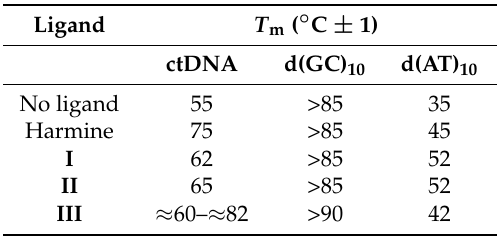
Figure 4. Normalised UV thermal denaturation curves of d(GC) 10 ( a ) and d(AT) 10 ( b ) in the absence and presence of ligands at 0.50 [ligand]:[DNA] bp ratio followed at 260 nm. Further base-dependent information came from the melting experiments performed with either d(GC) 10 (Figure 4a) or d(AT) 10 (Figure 4b). The melting temperatures in the case of d(AT) 10 complexes are well detected. On the contrary, the T m values of the d(GC) 10 complexes are invariably higher than 80 °C, but not accurately measured due to the upper heating limit both in the absence and in the presence of the ligands, as already reported in the case with GC sequences in similar experimental conditions [20,21]. In any case, III clearly makes the most stable complex with the d(GC) 10 , bearing